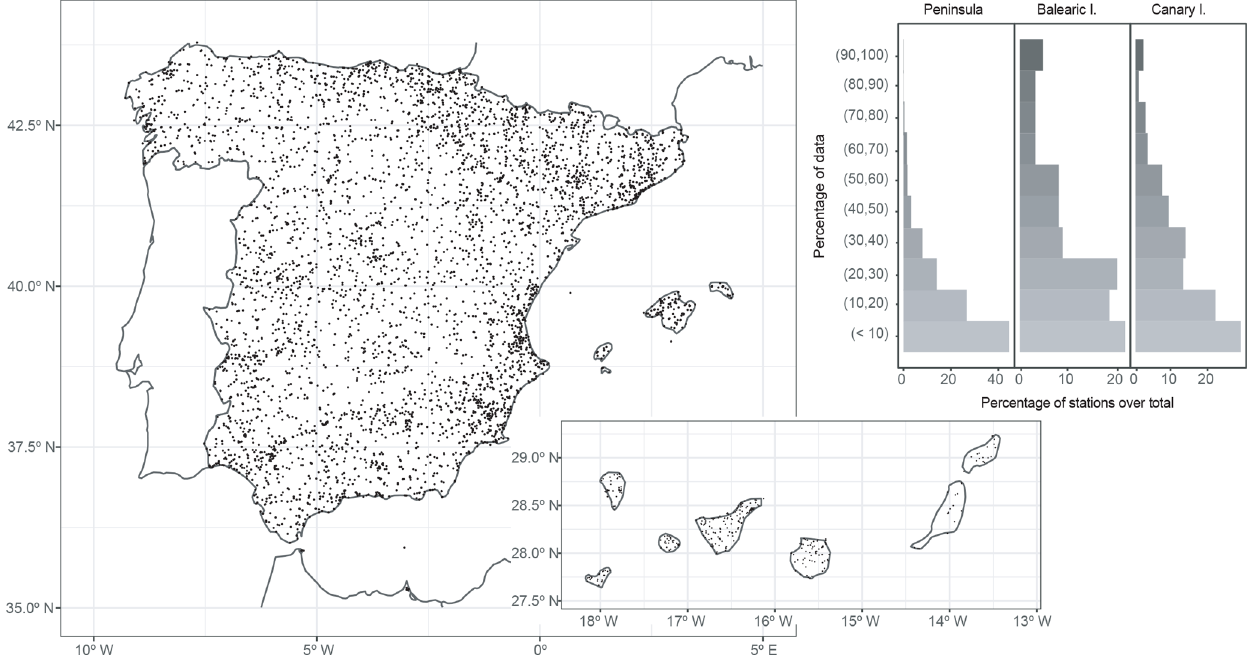
Figure 1. Location of the temperature stations and categorization by percentage of recorded data.